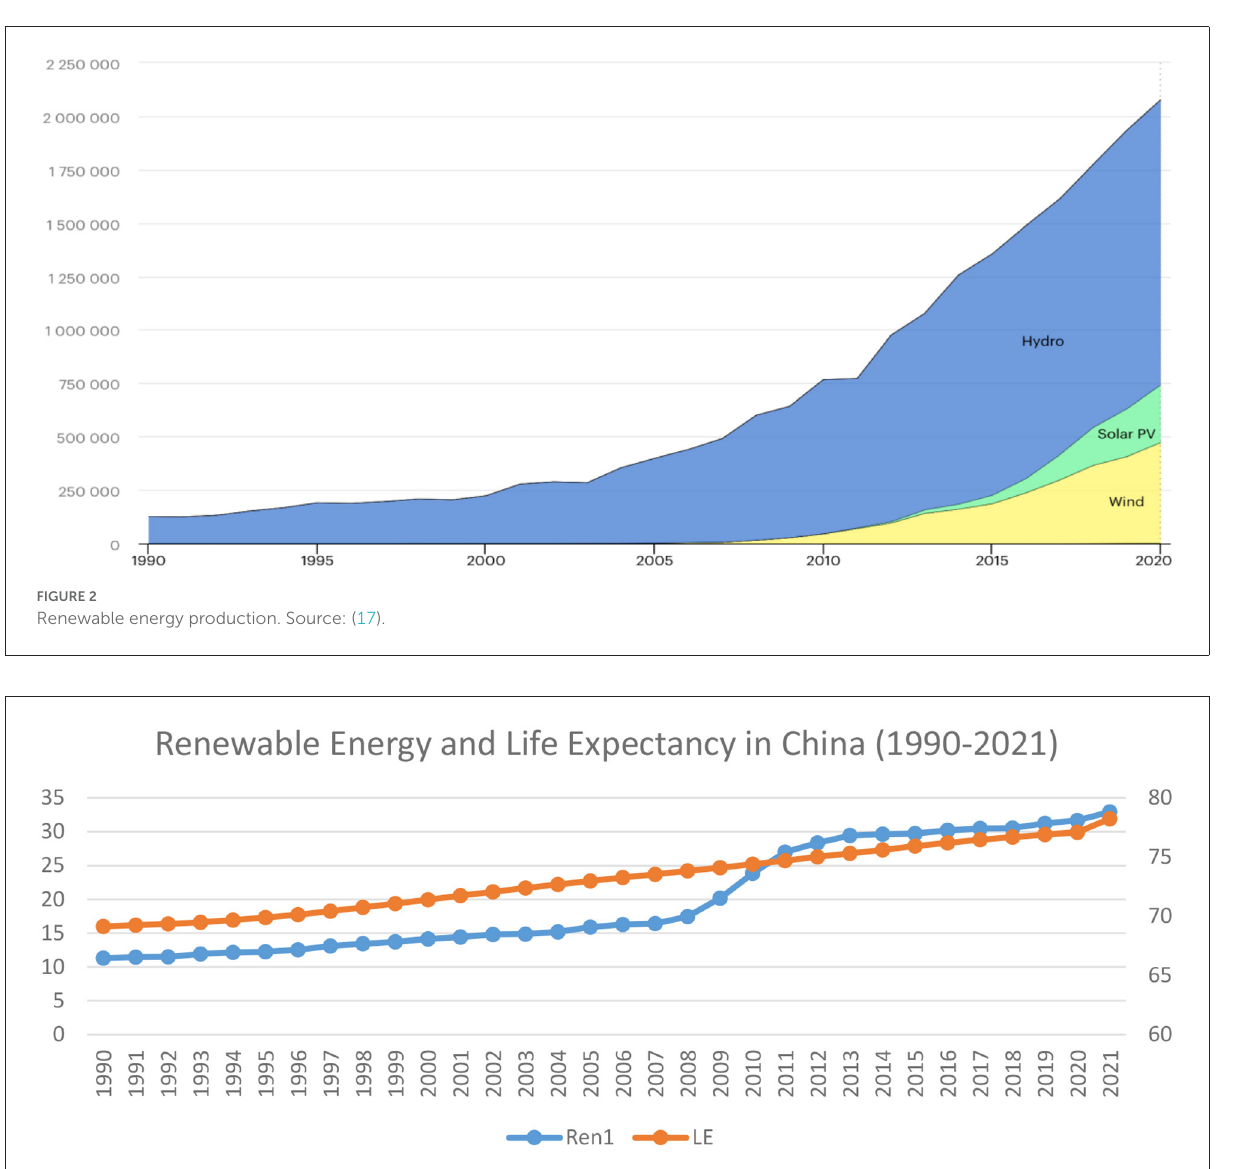
FIGURE3 Life expectancy and renewable energy consumption in China